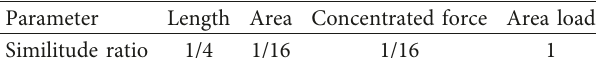
Figure 1: Typical structural plan of the framed core wall structure. (a) Original plan using the OCBs. (b) Optimized plan using the proposed SCBs. Table 1: Main similitude ratios involved this study.